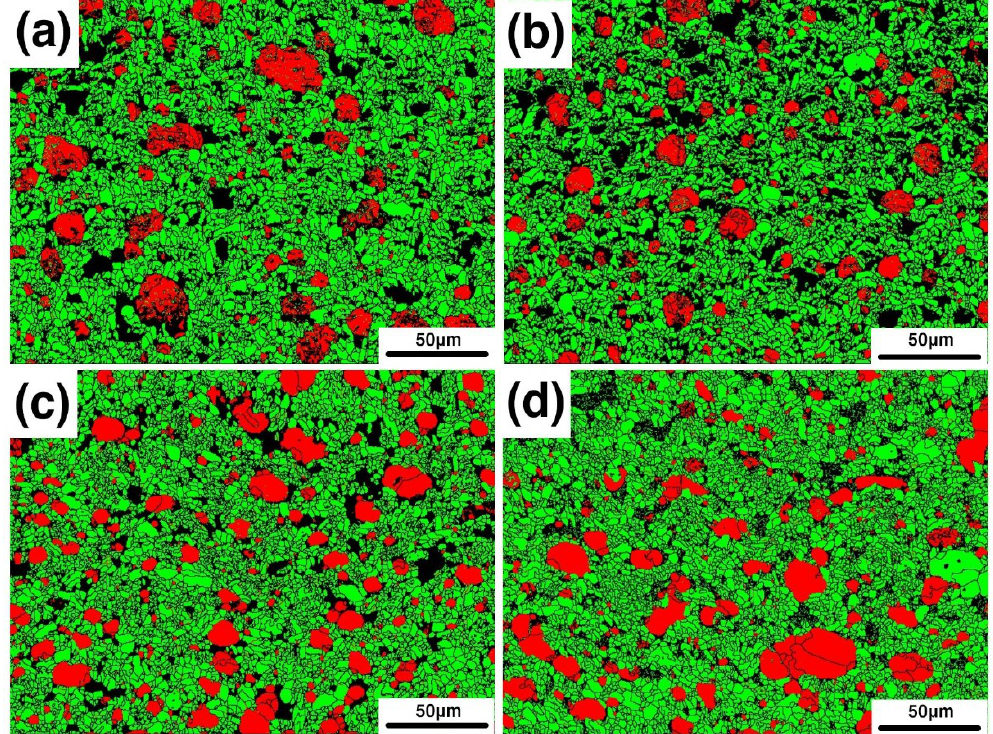
Figure 7. Phase distribution of samples B1 ( a ), B2 ( b ), B3 ( c ), and B4 ( d ).